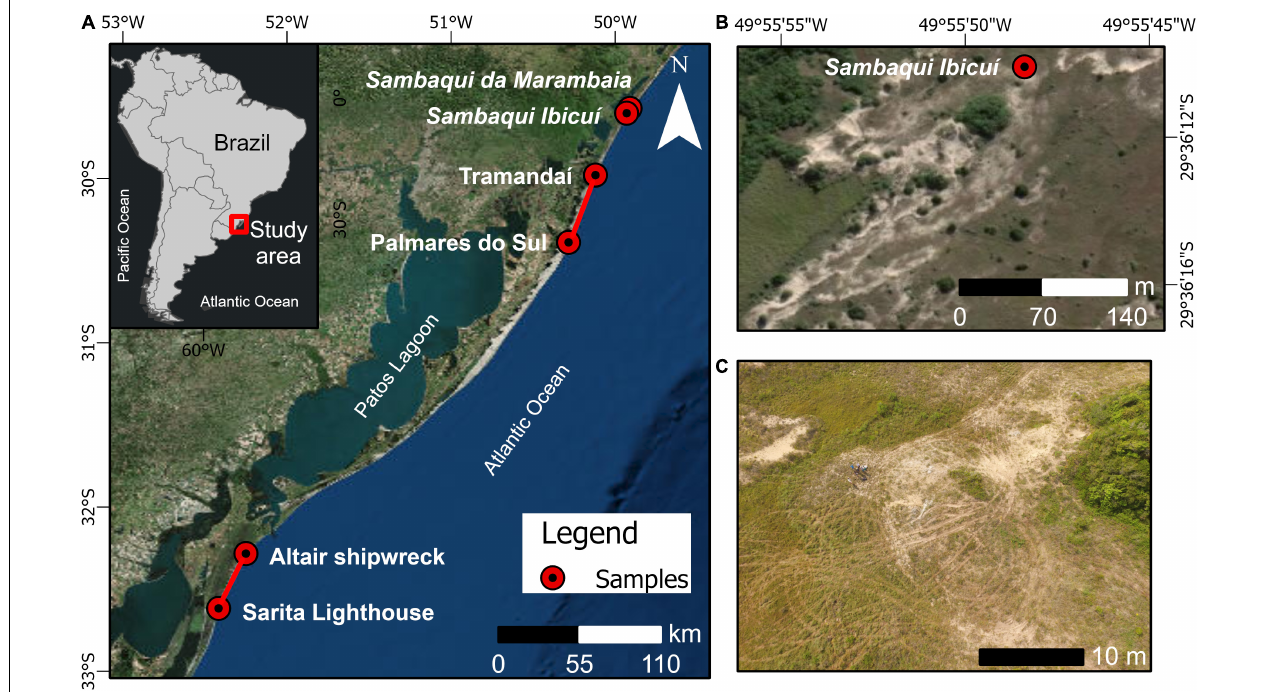
FIGURE 1 | Map of the study area showing (A) sample sites at the Coastal Plain of Rio Grande do Sul–Brazil, (B) the location of Sambaqui Ibicuí , and (C) a drone aerial photograph from Sambaqui Ibicuí depicting off-road vehicles tracks. Basemap–ArcView.